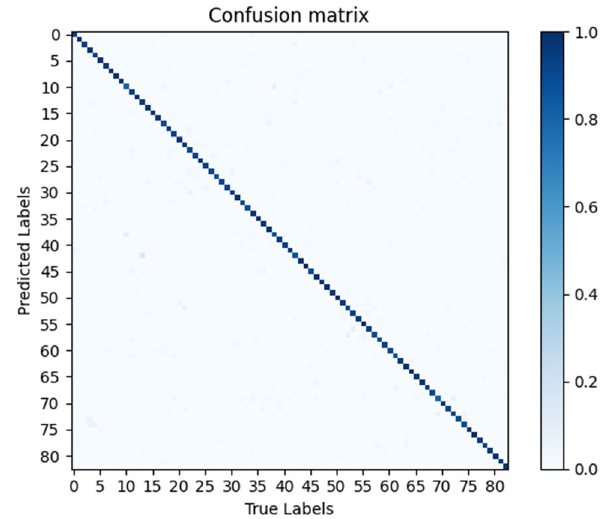
Fig. 10 Confusion matrix of